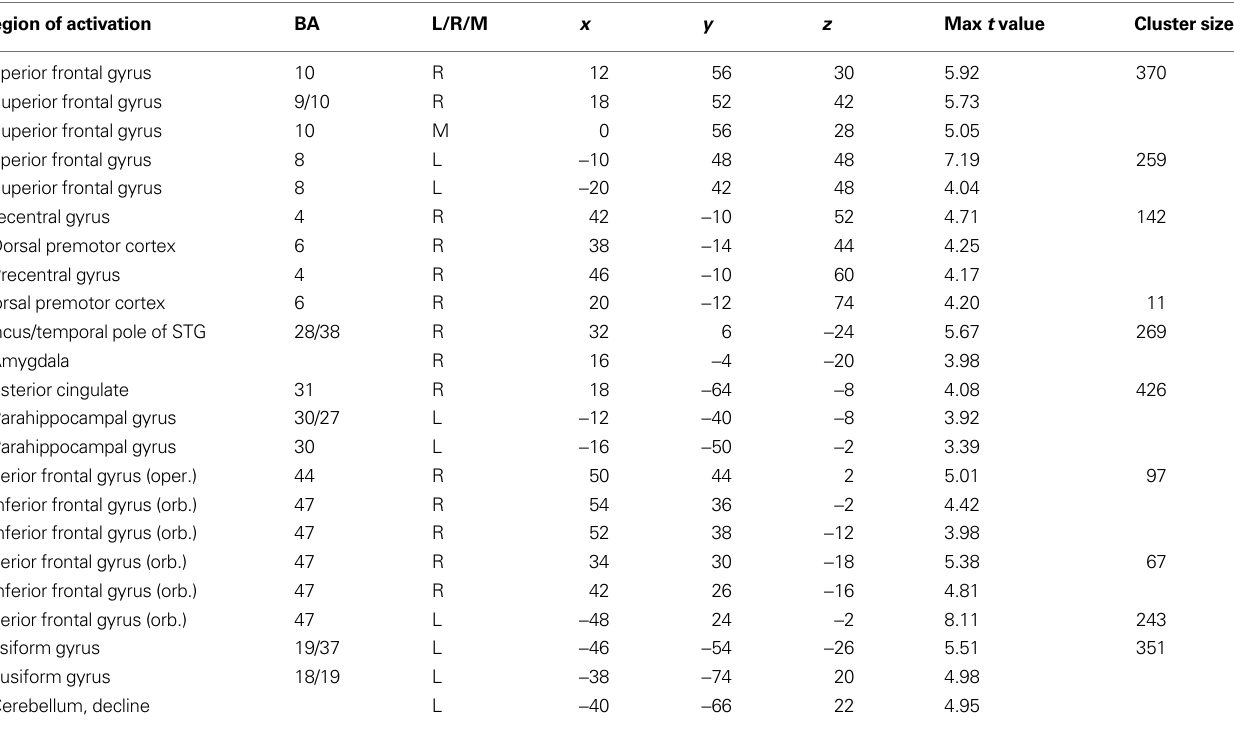
Table 1 | Regions of signifi cant activation during observation of the avatar in pain compared with no pain in a priori defi ned regions of interest. Coordinates in MNI space and maximum t values are shown for local voxel maxima in each cluster (SPM{t} maps thresholded at p < 0.001 uncorrected for multiple comparisons, with a cluster extent threshold of 10